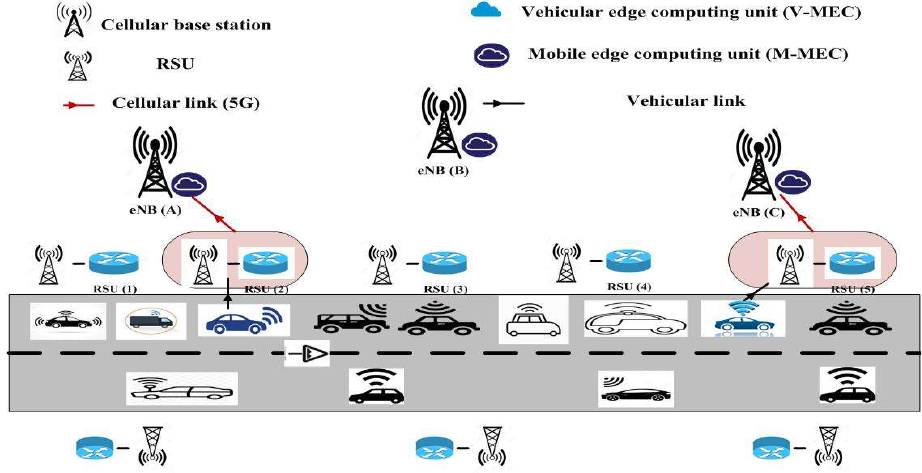
Figure 1. System structure of the developed MEC-based vehicular network.